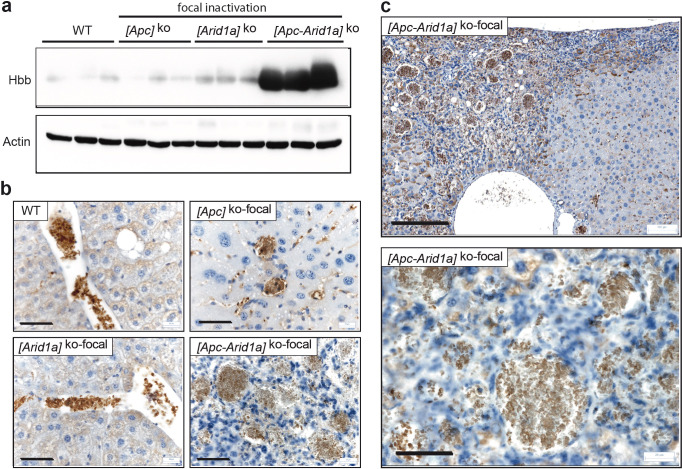
Hepato-specific and focal inactivation of Apc and Arid1a genes leads to sequestration of enucleated beta-globin-positive red blood cells.Western blot (a) and immunostaining (b, c) of hemoglobin subunit beta (Hbb) showing that Hbb-positive erythroid cells accumulated in [Apc-Arid1a]ko-focal livers are not nucleated, so do not correspond to immature and proliferative erythroblasts. Scale bars = 52 μm (b, c: bottom panel) or 200 μm (c: top panel).